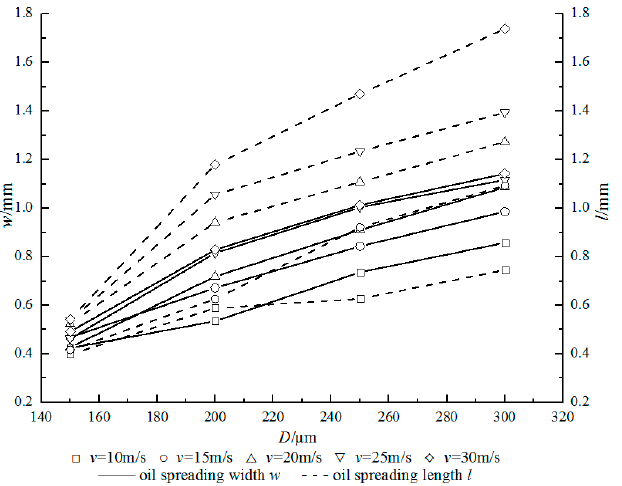
Figure 7. Effect of impacting velocity on spreading characteristics of deposited oil film when the incident angle is 60°.